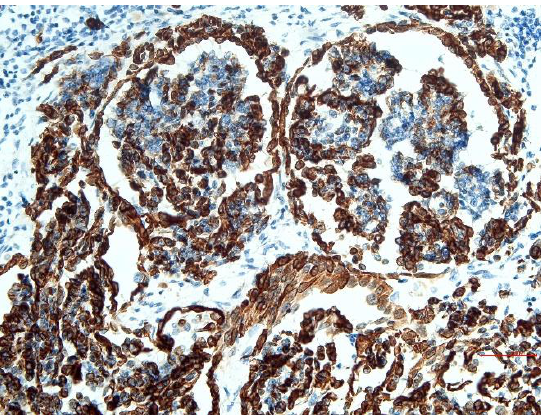
Figure 9. Lung: IHC cytokeratin: positivity over 75% of cancer cells. Bar = 60 µm.